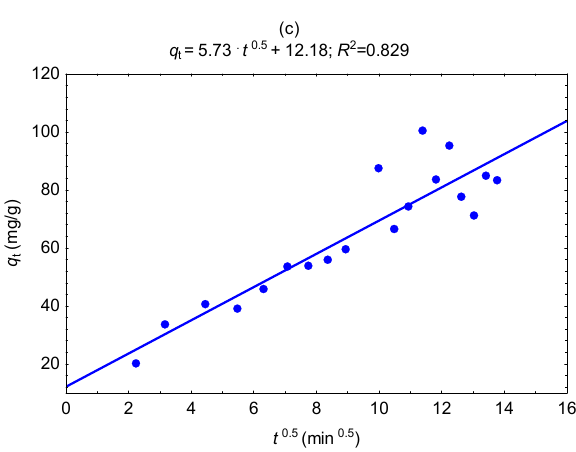
Figure 5. Kinetic plots for the biosorption of Cr(III) ions onto Cladophora glomerata biochar obtained at 450 °C applying different kinetic models ( a ) pseudo-second, ( b ) pseudo-first order model, ( c )